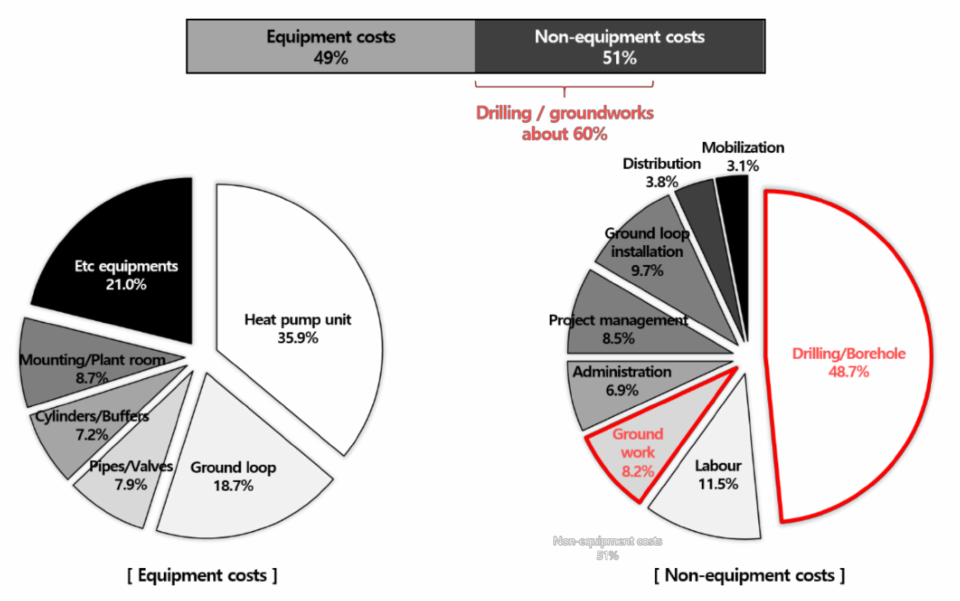
Figure 1. Construction costs of ground source heat pump (GSHP) systems [1].